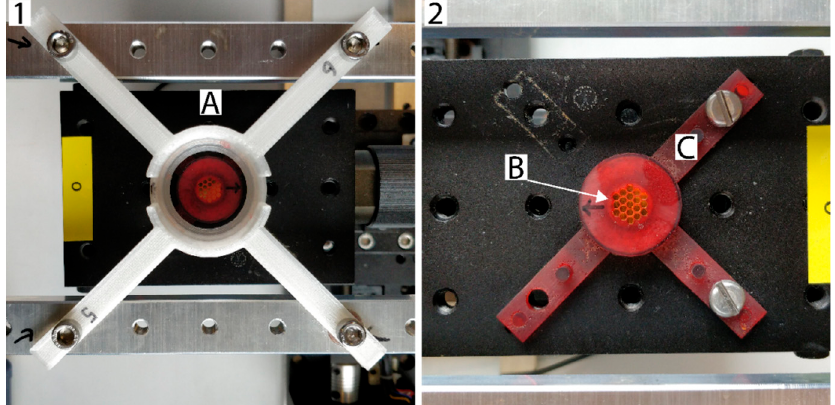
Figure 2. Top view of the irradiation set-up. Panel 1: ( A ) Top view with dish and source collimator in place. The source is aligned in the middle of the culture dish holder (Design S2). Panel 2: ( B ) Radioactive surface protected by gold inside the source collimator. ( C ) 3-D printed source collimator (Design